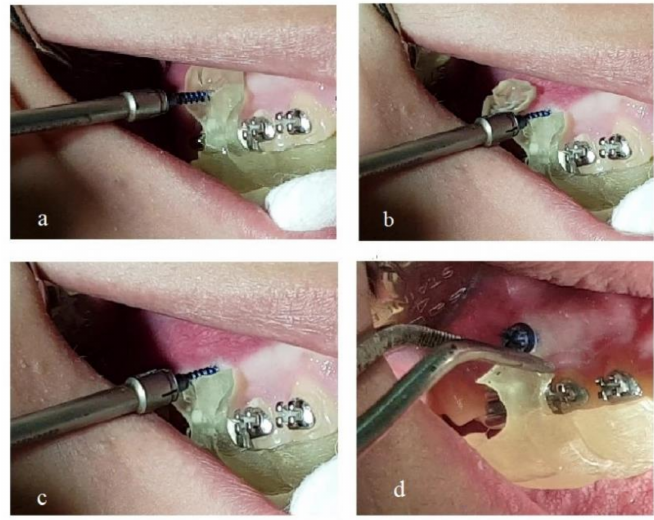
Figure 3. ( a ) Mini-implant inserted through the guiding hole of the surgical guide. ( b ) Guide’s small part beyond the mini-implant broken to pieces under screwing pressure. ( c ) Broken pieces of the guide removed. ( d ) The guide released from the mouth.